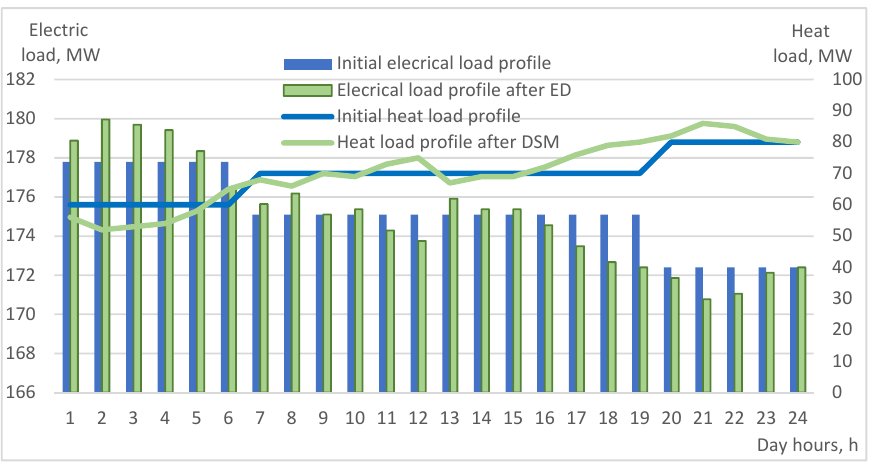
Figure 3. Electric and heat load profile before and after economic dispatch according to demand-side management.